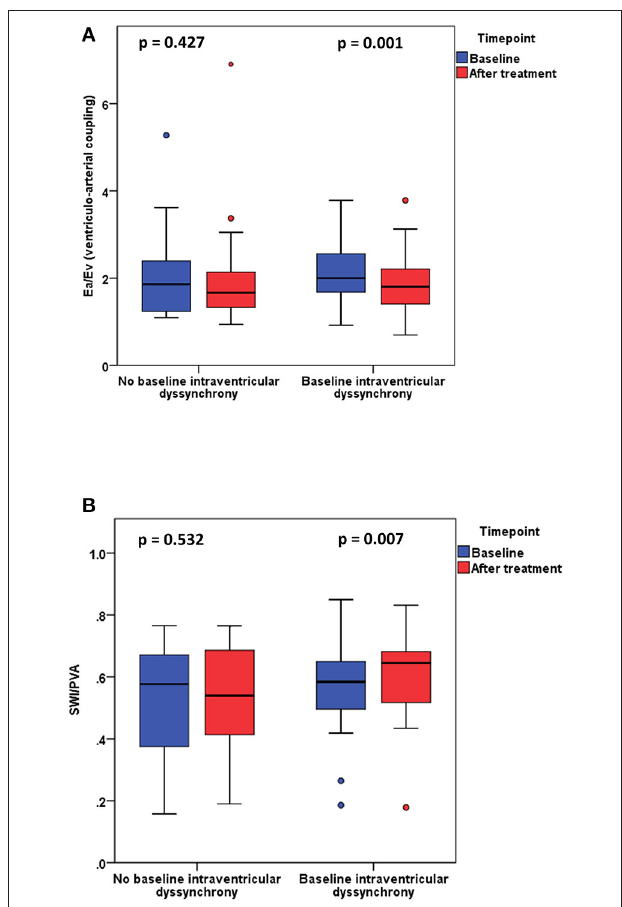
FIGURE 3 | (A) Ventriculo-arterial coupling (E A /E V ) before and after treatment in patients with and without baseline intraventricular dyssynchrony. (B) Stroke work index/pressure volume area (SWI/PVA) before and after treatment in patients with and without baseline intraventricular